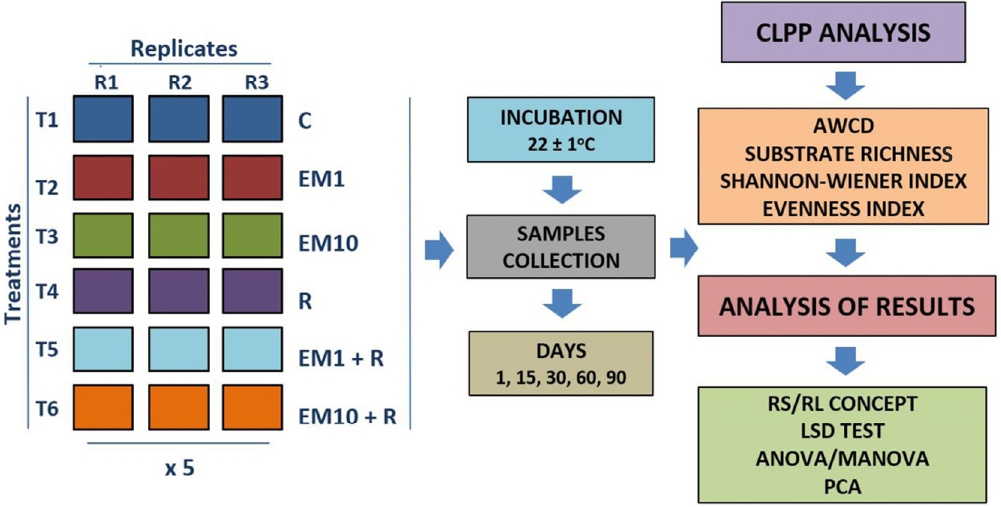
Figure 2. Experimental design and analyses performed. C = control. EM1 = erythromycin (1 mg/kg soil). EM10 = erythromycin (10 mg/kg soil). R = Raoultella sp. strain MC3. CLPP = community-level physiological profile. AWCD = average well-color development. RS = resistance. RL = resilience. LSD = least significant differences. ANOVA = analysis of variance. MANOVA = multivariate analysis of variance. PCA = principal component analysis.